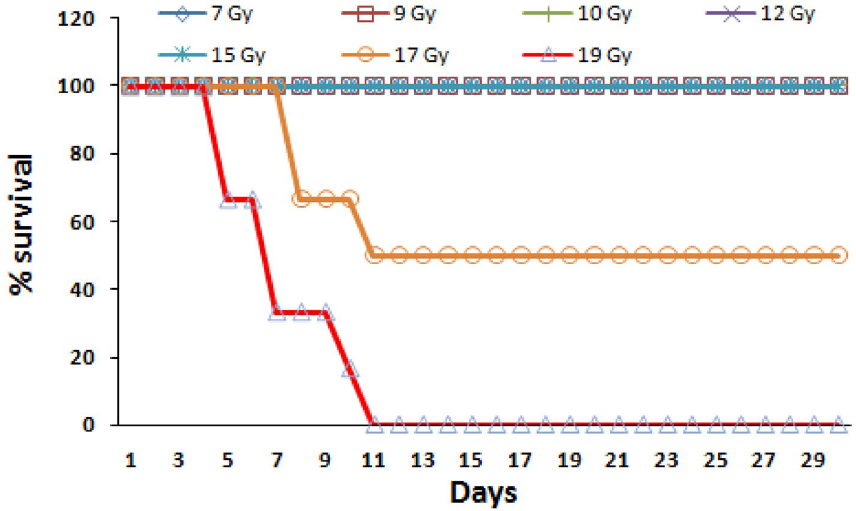
Figure 2. Effect of various doses of radiation (localized exposure to both femurs) on mice survival. All the animals survived in 7, 9, 10, 12, 15 Gy localized irradiation group with LD 50 and LD 100 as 17 and 19 Gy respectively. For survival assay, mice were randomly divided into seven groups of six mice in each group and observed for a period of 30 days for radiation induced morbidity and mortality. Survival experiment was independently repeated thrice. Data obtained was statistically analyzed and represented by a Kaplan–Meier survival